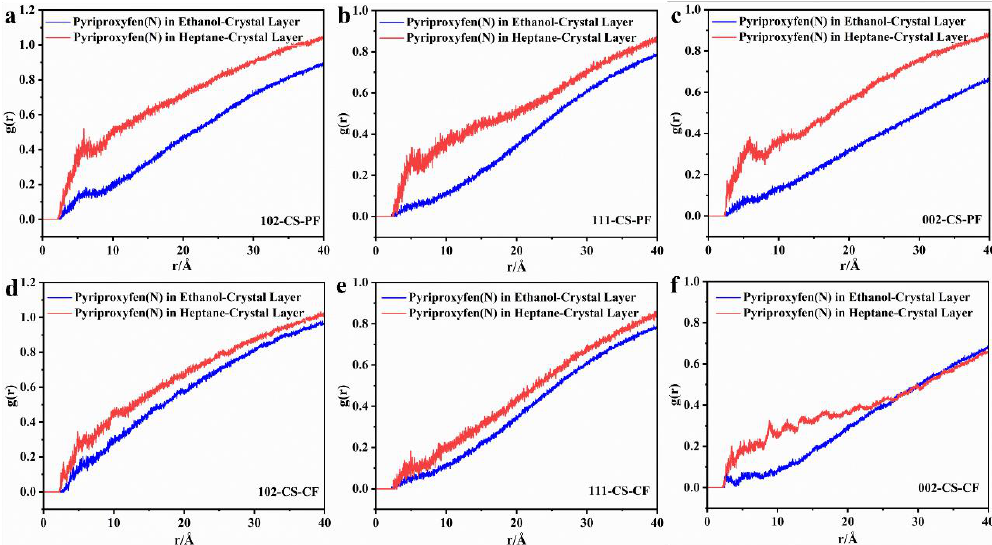
Figure 6. RDFs of the solute pyriproxyfen (N) to crystal layer in different solution environments. ( a – c ) The models with partly relaxed crystal layer in (102) face, (111) face, and (002) face, respec- tively. ( d – f ) The models with completely fixed crystal layer in (102) face, (111) face, and (002) face, respectively.